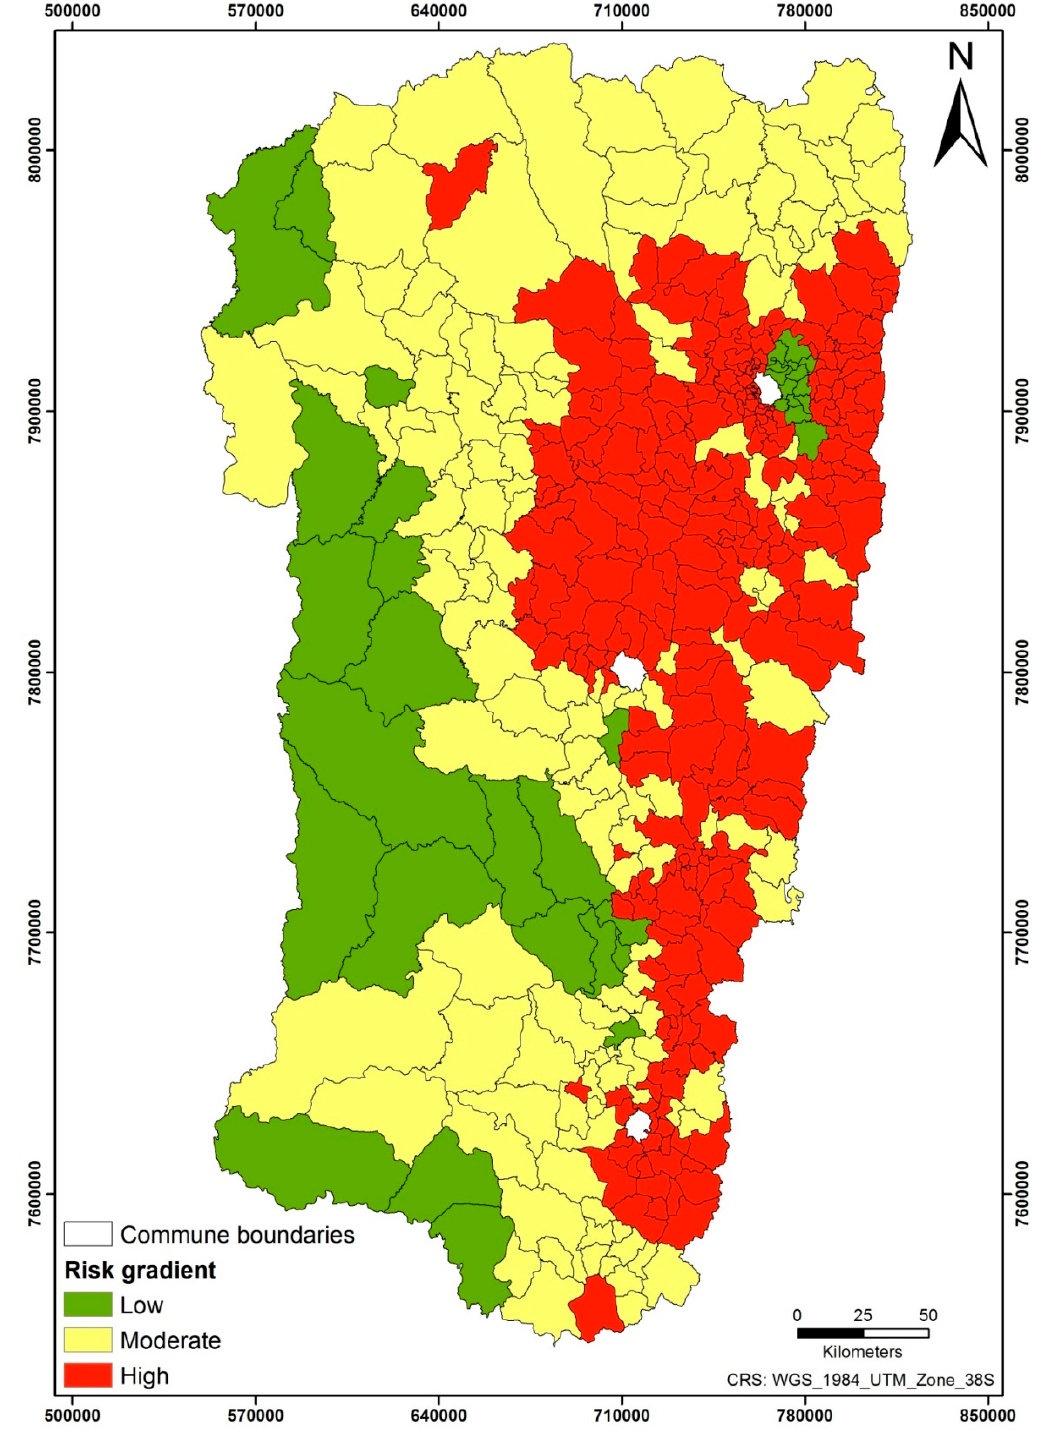
Figure 4. Suitability map in 2016 adjusted to a commune scale.